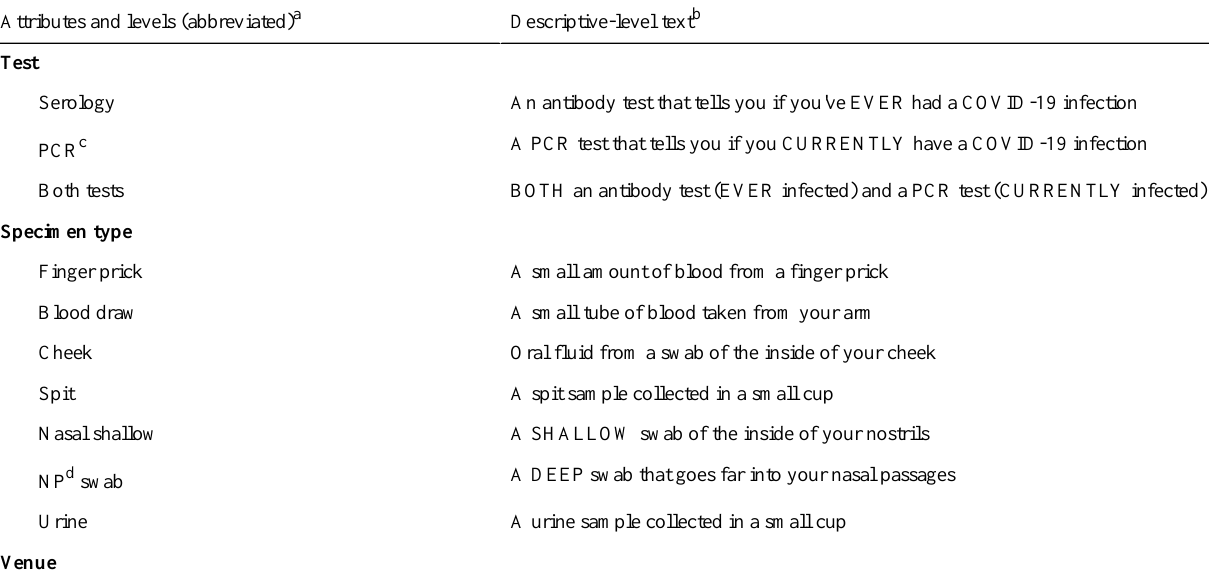
Descriptive-level text b Attributes and levels (abbreviated)